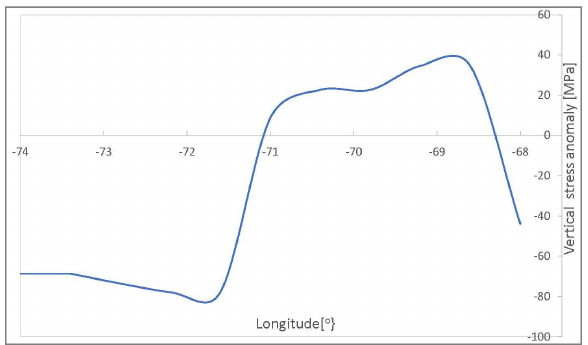
Figure 6: Vertical stress anomalies on top of the subducting Nazca plate along East-West transect at 19 ◦